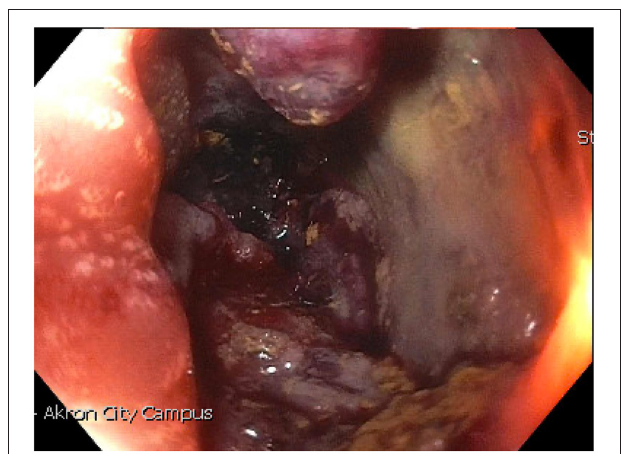
FIGURE 5 | Mucosal ischemia at level of stenosis from external compression.